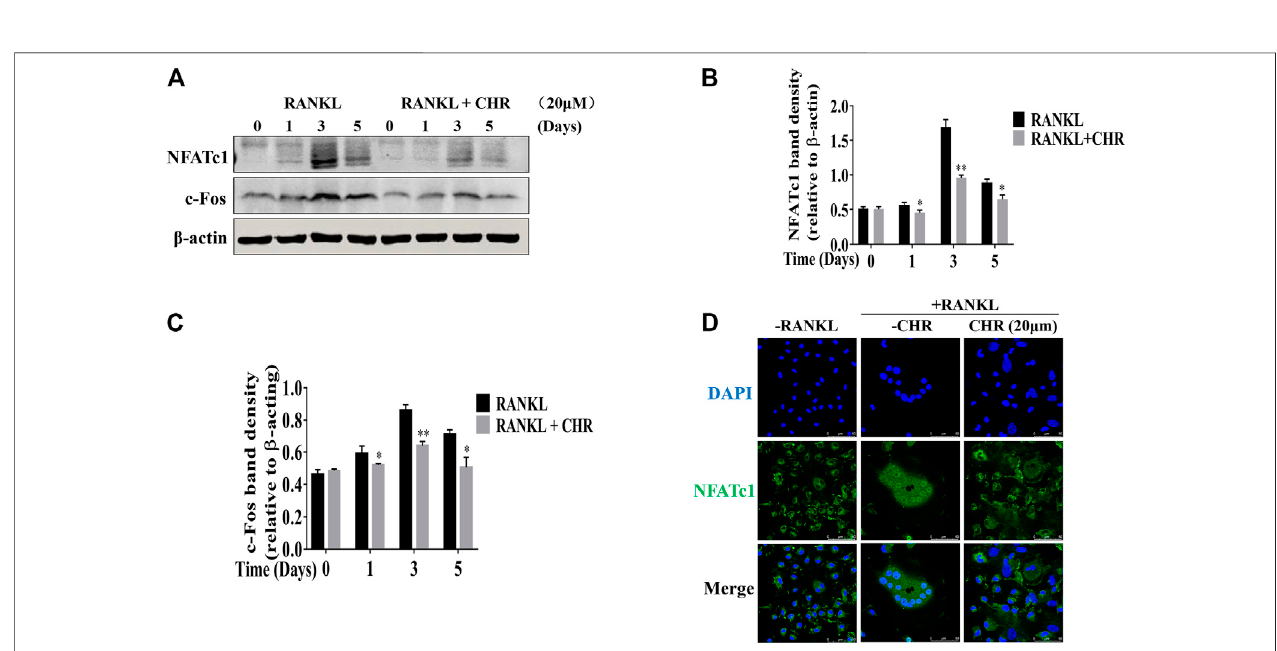
FIGURE 5 | CHR inhibited RANKL induced C-fos and NFATc1 protein expression. (A) Murine BMMs were cultured with 30 ng/ml M-CSF and 100 ng/ml RANKL absenceorpresenceof20 μ MCHRfor1,3,or5 daysandwerelysedandtotalcellularproteinextractsweresubjectedtowesternblotanalysisusingspeci fi cantibodies to NFATc1 and c-Fos. Antibody to β -actin was used as internal loading control. The relative density of protein bands for (B) C-fos and (C) NFATc1 against β -actin was quanti fi ed using ImageJ. (D) Immuno fl uorescence staining for nuclear localization of NFATc1 (n = 3) (* p < 0.05, ** p < 0.01, *** p < 0.001).